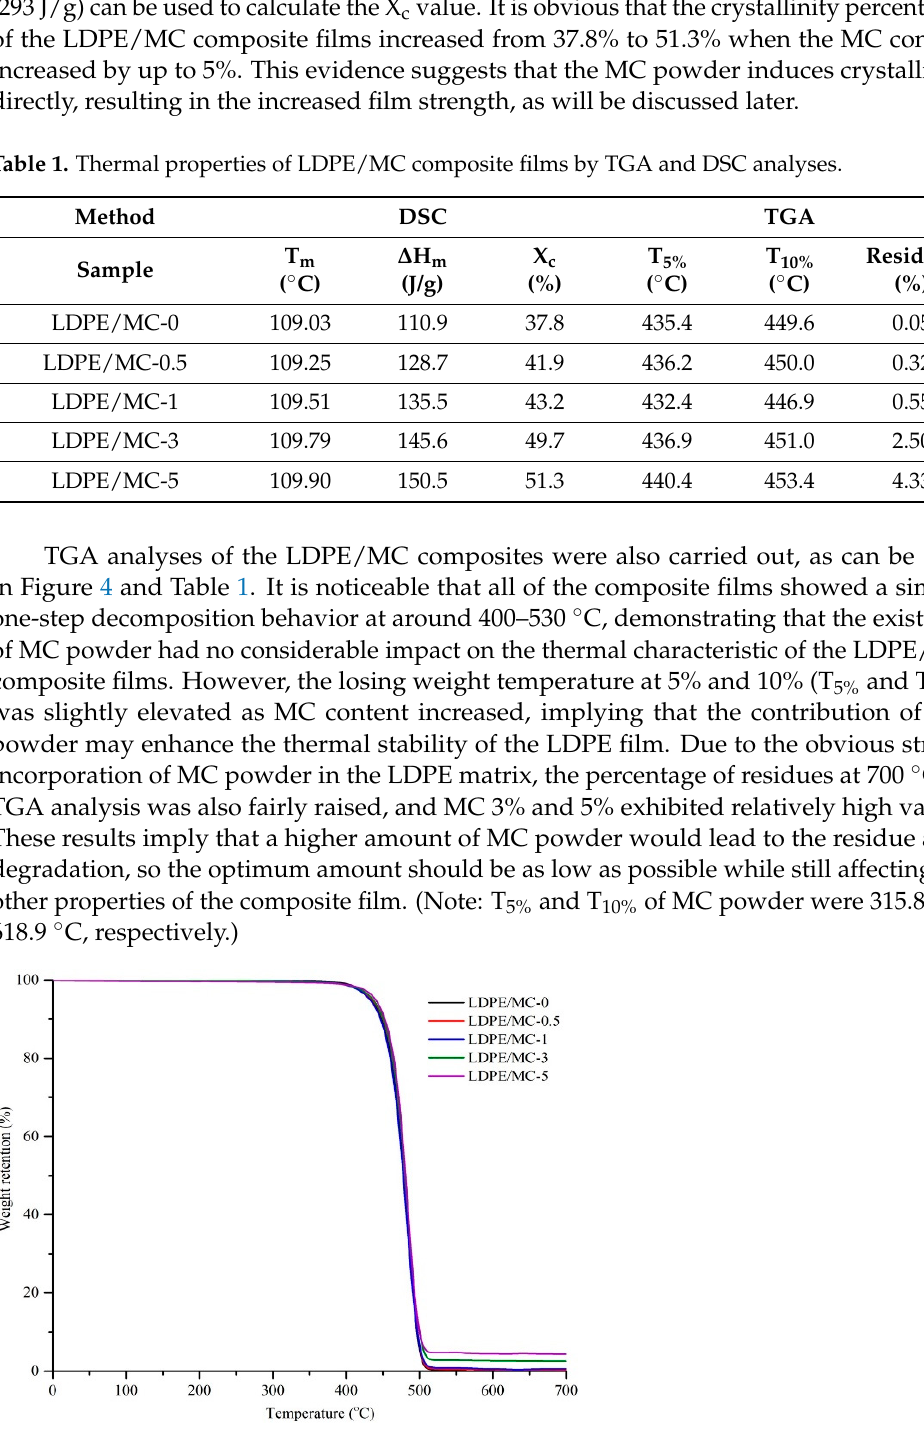
Figure 4. TGA thermograms of LDPE/MC composites films at various MC concentrations.